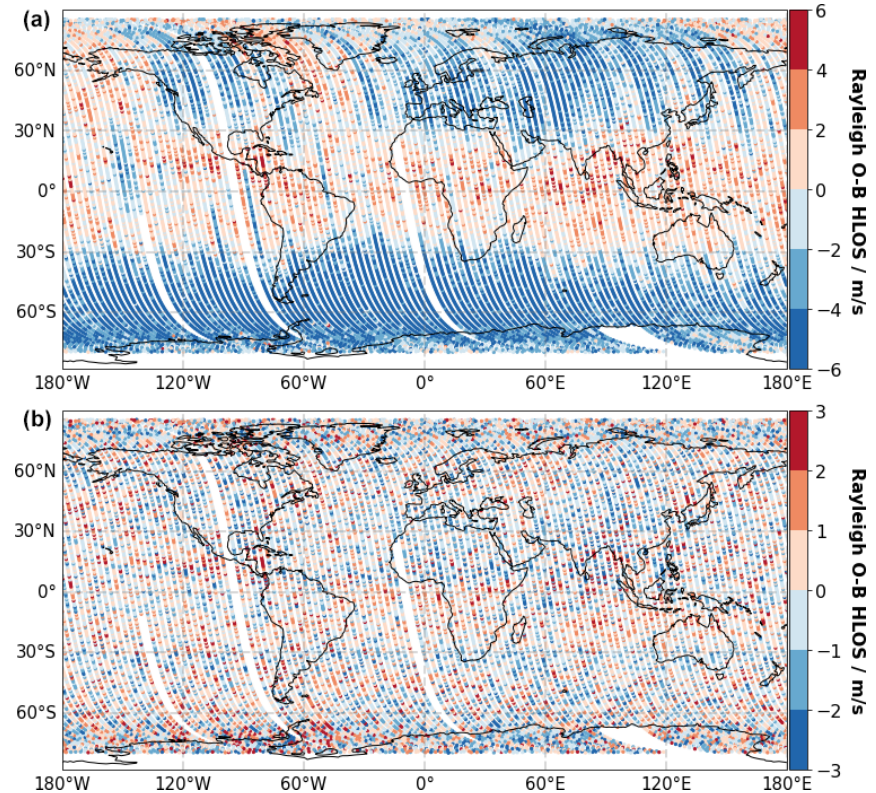
Figure 14. Global distribution of the Rayleigh clear E(O − B) HLOS values, vertically averaged over all range gates, before (a) and after (b) the M1 bias correction. A total of 1 week of data (111 orbits, only ascending orbits) from 15 to 22 August 2019 is shown. The gaps are due to calibration procedures such as “hot-pixel-related” calibration measurements or calibration measurements of the internal path.